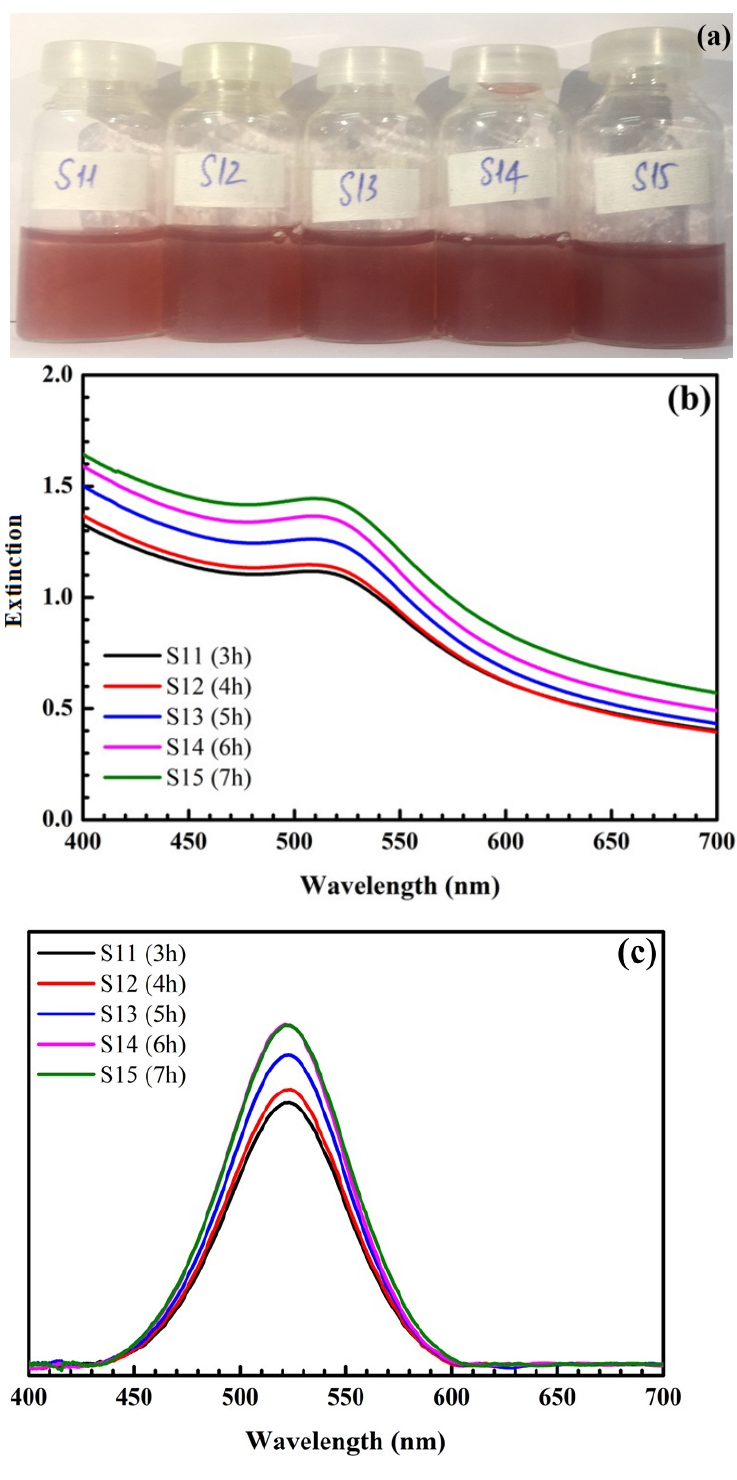
Figure 2. Pictures of samples at different reaction times ( a ). UV-Vis spectra of samples at different reaction times ( b ) and their UV-Vis baseline spectra ( c ) .